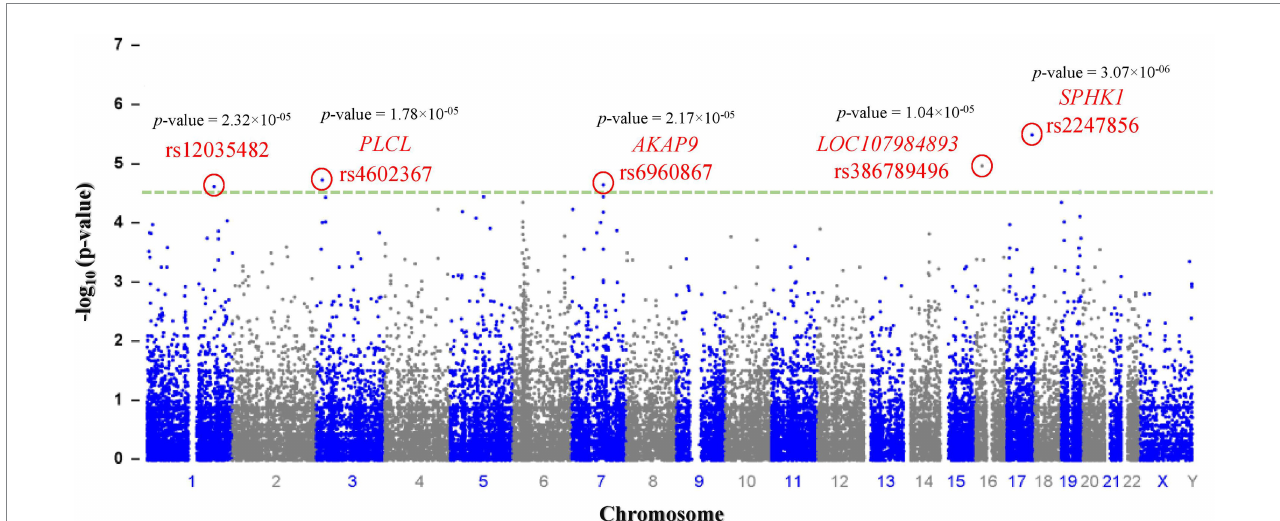
FIGURE 1 Manhattan plot: a total of ( n = 243,345) SNPs are plotted according to p -values ( y -axis) and their position in the genome ( x -axis). The most significant candidate nucleotide variants rs2247856 ( SPHK1 ), rs386789496 ( LOC107984893 ), rs4602367 ( PLCL ), rs6960867 ( AKAP9 ) and rs12035482 on chromosome 17, 16, 3, 7and 1 respectively, exceed the significance threshold line ( p = 1.00 × 10 –4.5 - green dash line) indicating a statistically significant correlation with autism.